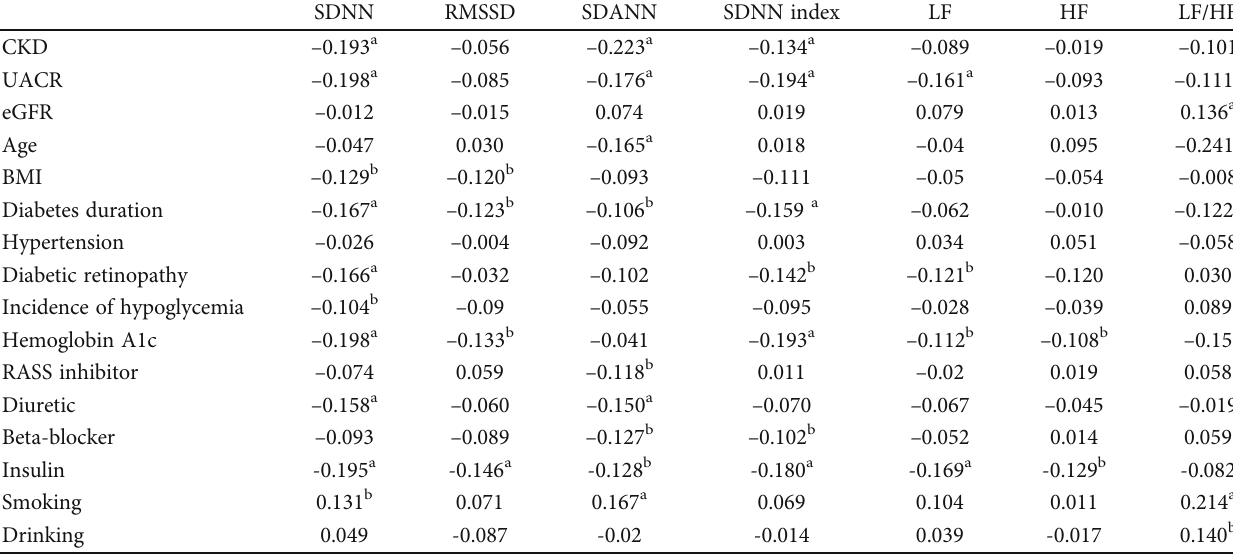
Table 3: Spearman ’ s correlation analysis between di ff erent clinical characteristics and HRV analyses.